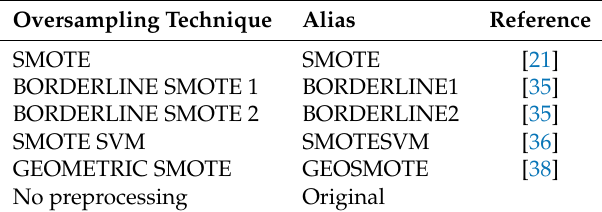
Table 2. Oversampling techniques.